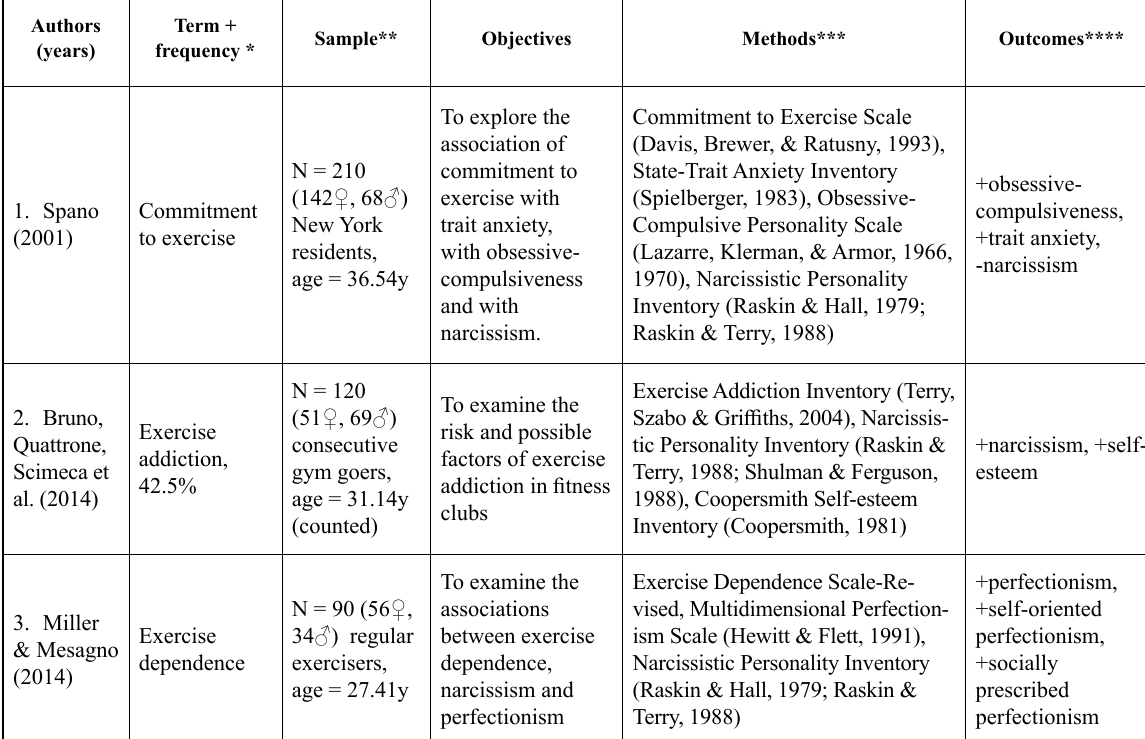
Table 4. Summary of studies between 1995 and 2016 investigating the relationship between exercise addiction and